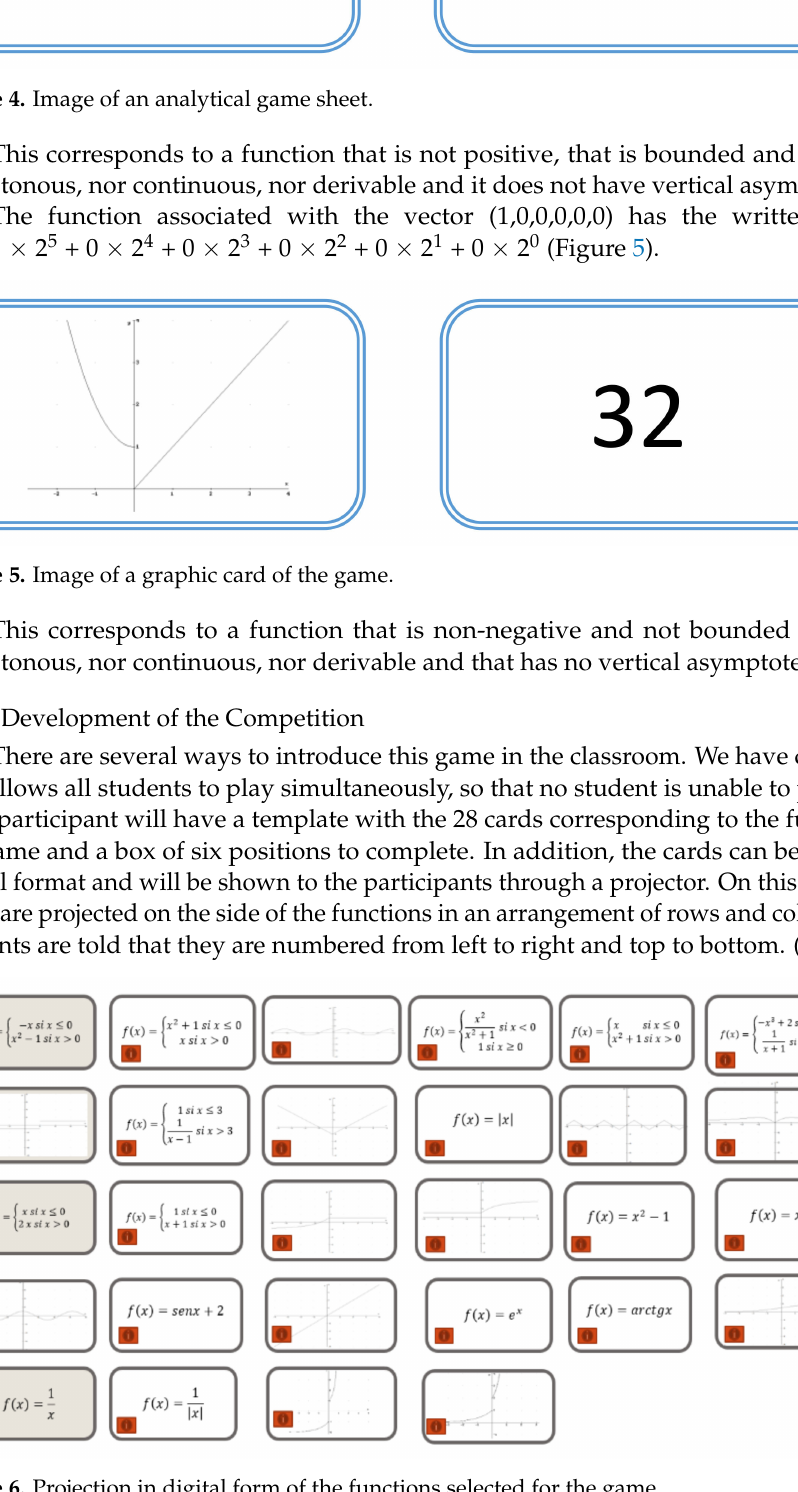
Figure 6. Projection in digital form of the functions selected for the